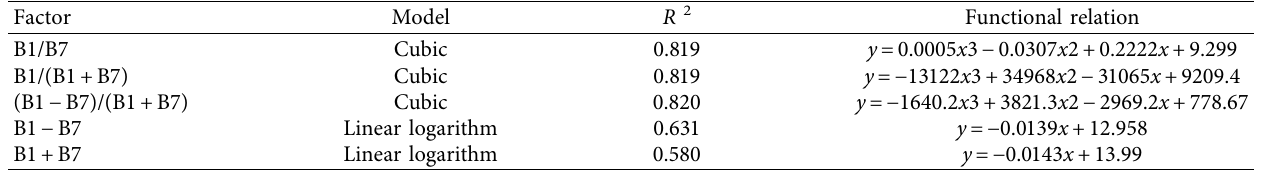
Table 7: Fitting model of DO concentration.